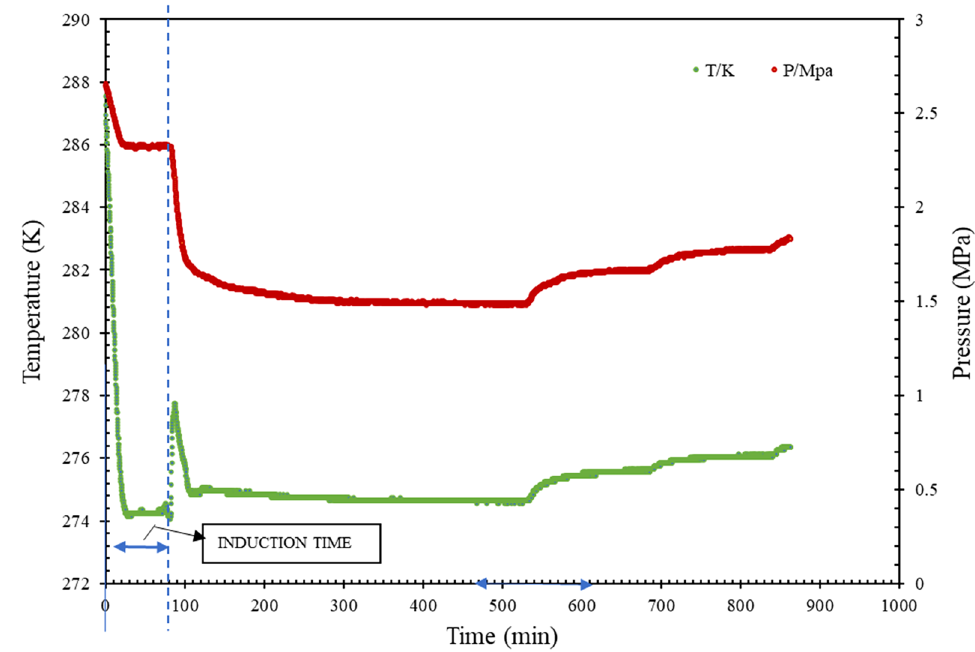
Figure 4. Pressure/temperature vs. time ( t ) curve to find induction time.